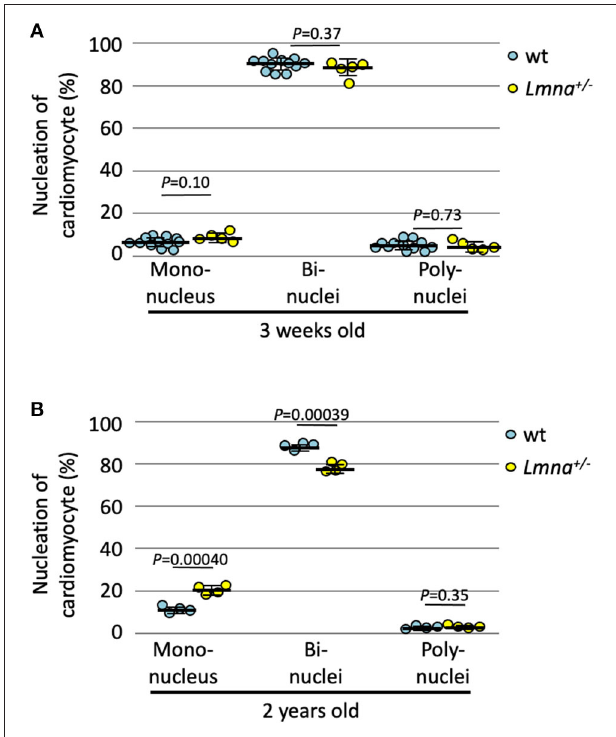
FIGURE 3 | Nucleation of cardiomyocytes in young and old wild type (wt) and Lmna + / − mice. (A) Nucleation of cardiomyocytes in 3 weeks old ( n = 12 in wt and 5 in Lmna + / − ) was similar between wt and Lmna + / − mice. (B) Nucleation of cardiomyocytes in 2 years old ( n = 4 in each group) showed more mononuclear and less binuclear cardiomyocytes in Lmna + / − mice. Dots represent individual mouse data. The significance of differences between two groups was determined using the Student’s 2 tailed T